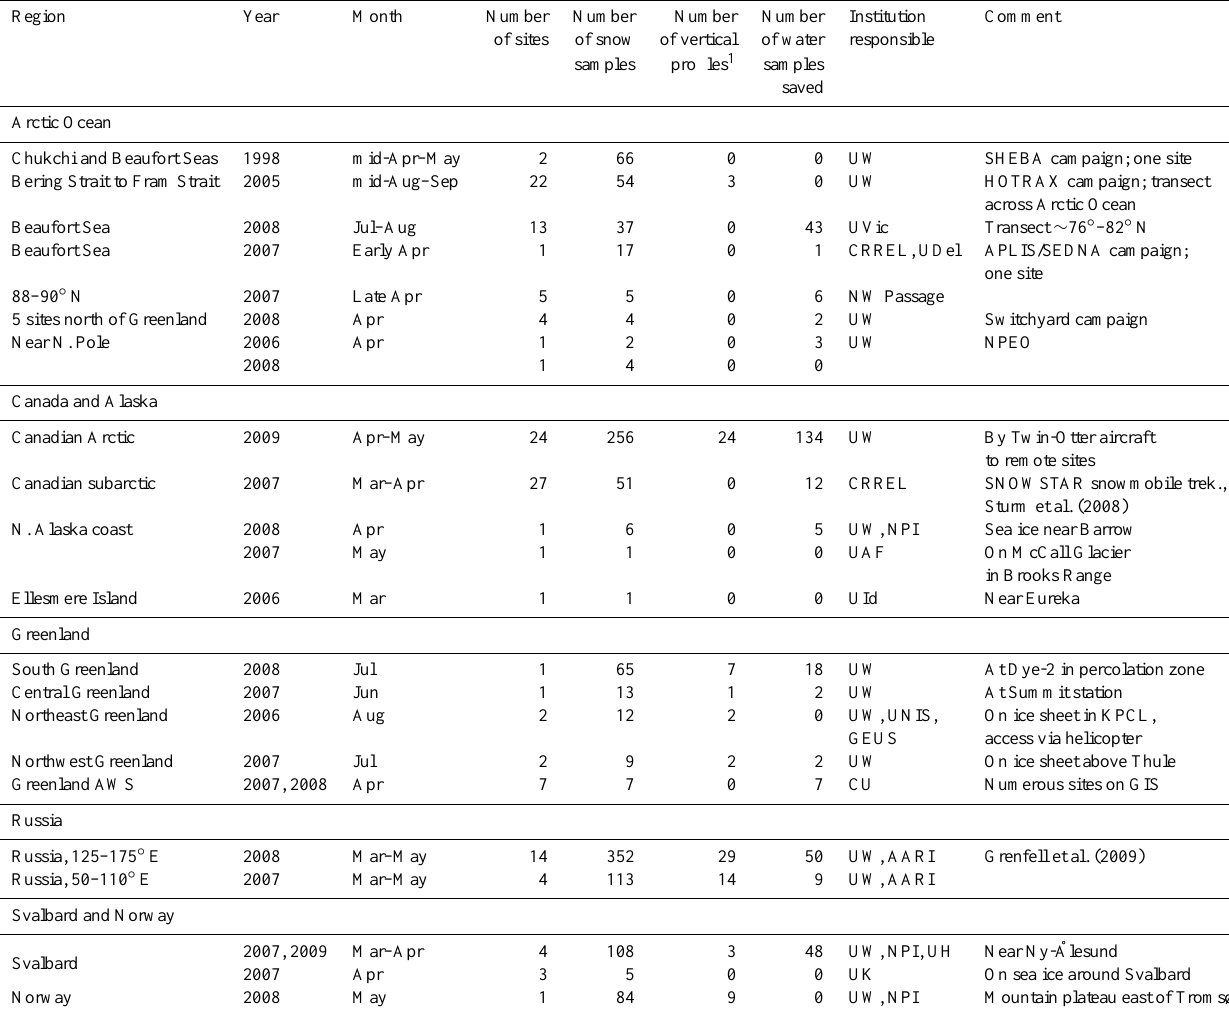
Table 1. Field campaigns within each region, listed in order of the number of snow samples obtained.